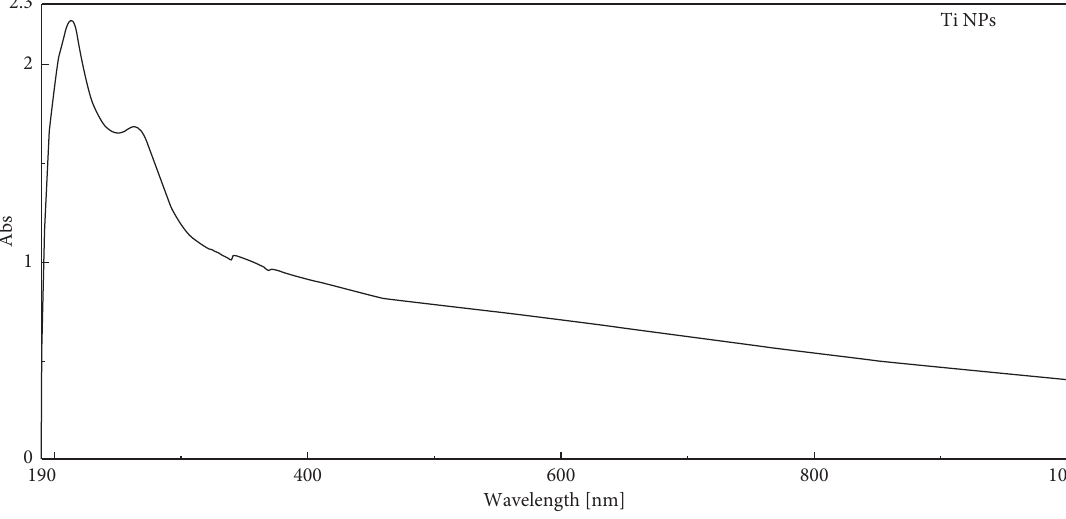
Figure 2: Te UV-vis shows the spectrum of TiO2 NPs synthesized using A. herb Alba aqueous leaf